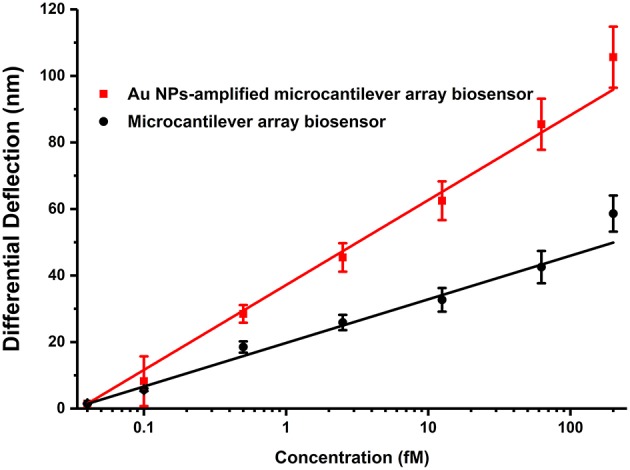
Effect of modification by Au NPs.